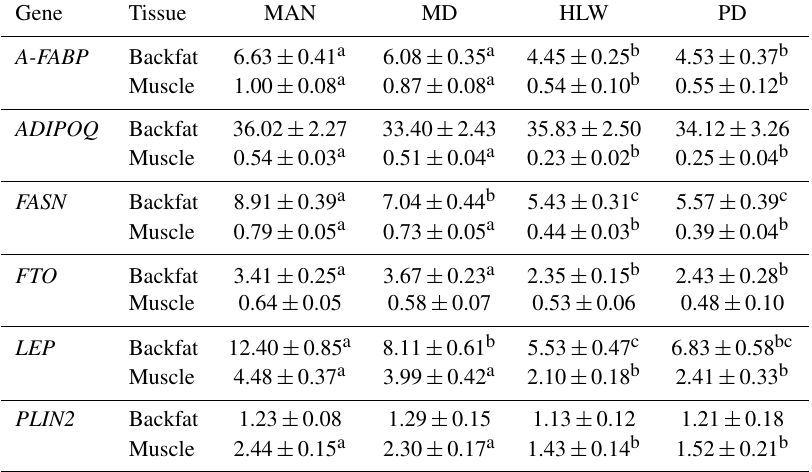
Table 3. Normalized fold expression (mean ± SEM) of A-FABP , ADIPOQ , FASN , FTO , LEP , and PLIN2 genes in backfat and muscle tissues of MAN, MD, HLW, and PD